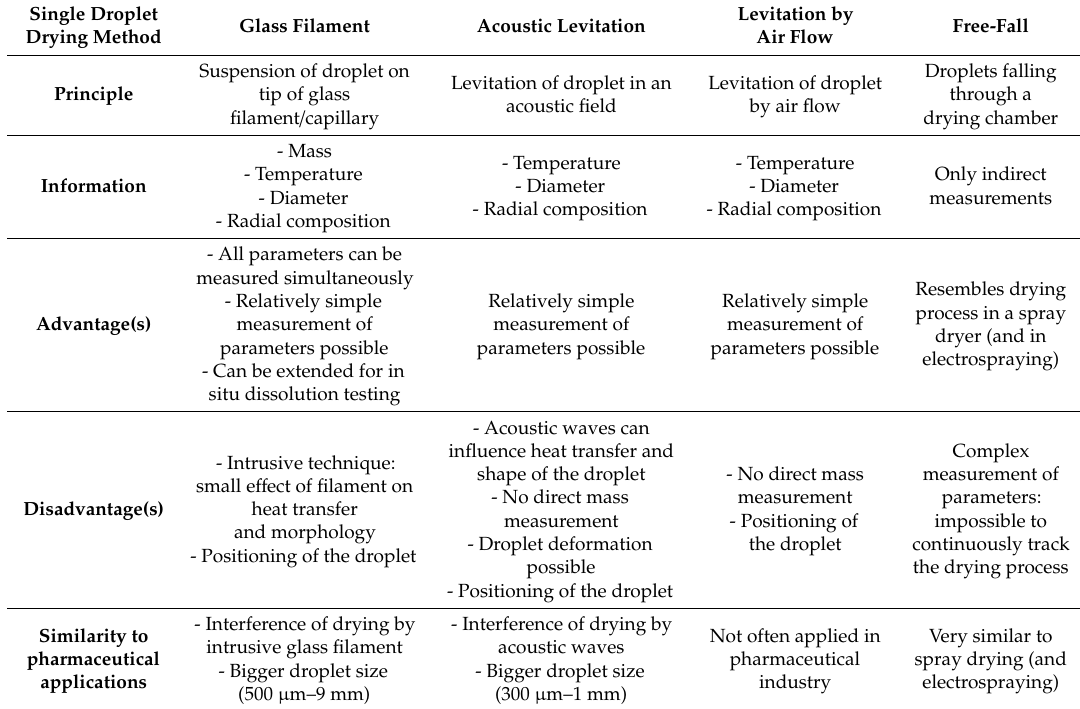
Table 1. Comparison of single droplet drying methods: Principles, information, (dis)advantage(s), and similarity to pharmaceutical applications